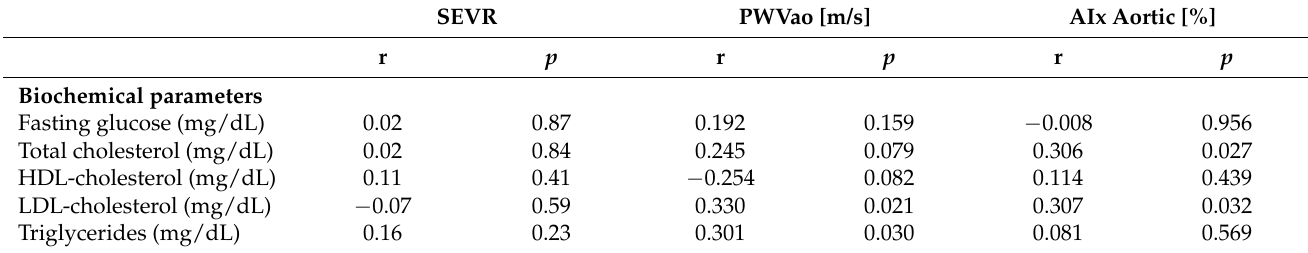
Table 4. Correlations between SEVR and hematological, biochemical parameters, or arterial stiff- ness